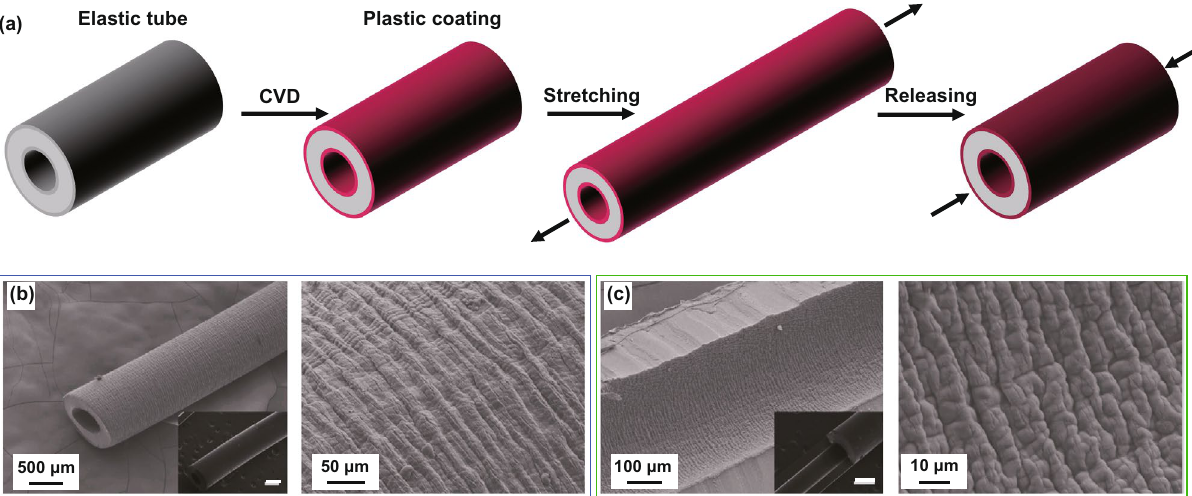
Fig. 11 The fabrication of wrinkling patterns on the inner surface of a cylindrical tube. a Schematic of the fabrication process for wrinkling patterns on internal surface of a silicone rubber tube: plastic coating on inner and outer surface of the tube can be obtained via chemical vapor deposition, and then wrinkling patterns on the exterior and the interior surface can be induced via stretching and then releasing the plastic/elastic bilayer. The inner and outer diameters of the tube are 0.5 and 1 mm, respectively. Insets of b and c represent the smooth tube before wrinkling and the scale bars in the insets are 500 μm [181]. Copyright 2016 American Chemical